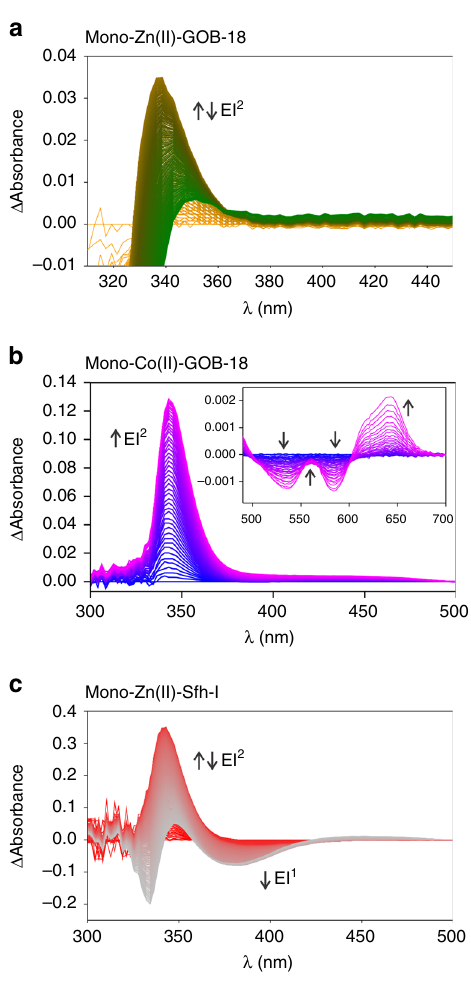
Fig. 2 Electronic absorption spectra of imipenem hydrolysis catalysed by mononuclear M β Ls. a Sequence of difference spectra upon the reaction of 91 μ M imipenem and 51.4 μ M Zn(II)-GOB-18. The reaction progresses from yellow to green spectra. The time interval covers up to 50 s. b Sequence of difference spectra upon the reaction of 3.5 mM imipenem and 430 μ M mono-Co(II)-GOB-18. The reaction progresses from blue to pink spectra. The time interval covers from 14.7 to 26.6 s. The inset shows a magni fi cation of the 450 – 700 nm region. c Sequence of difference spectra upon the reaction of 3 mM imipenem and 350 μ M mono-Zn(II)-Sfh-I. The reaction progresses from red to grey spectra. The time interval covers up to